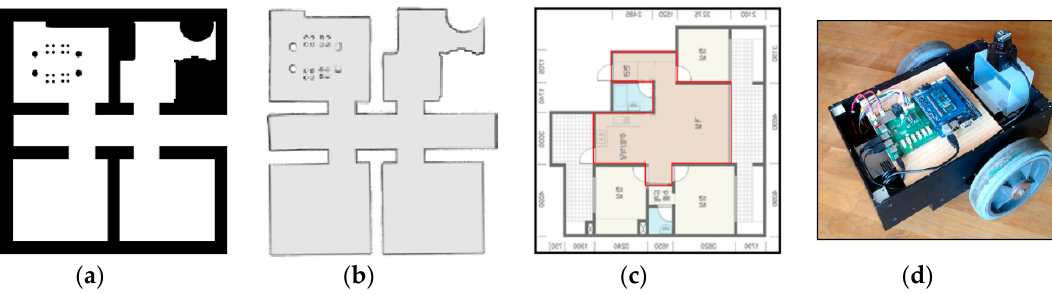
Figure 8. The experiment environments. ( a ) The simulated environment using player/stage; ( b ) The grid map produced by DP-SLAM for (a) environment; ( c ) The real environment; ( d ) The robot the authors built.